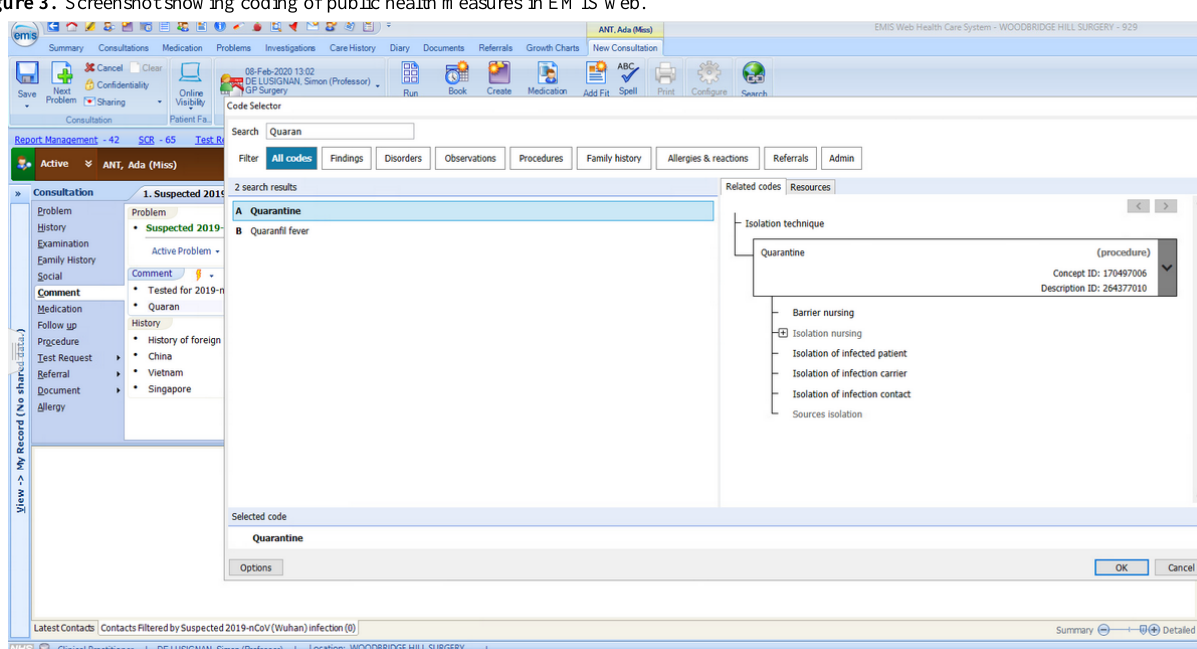
Figure 3. Screenshot showing coding of public health measures in EMIS